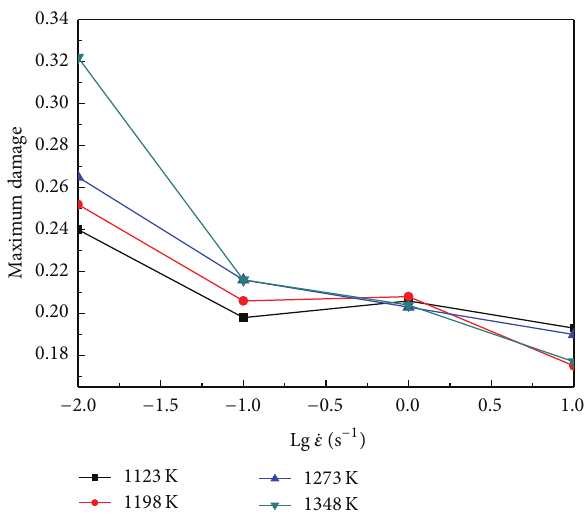
Figure 6: The relationships between maximum damage and strain rate at the end of compressing process under different